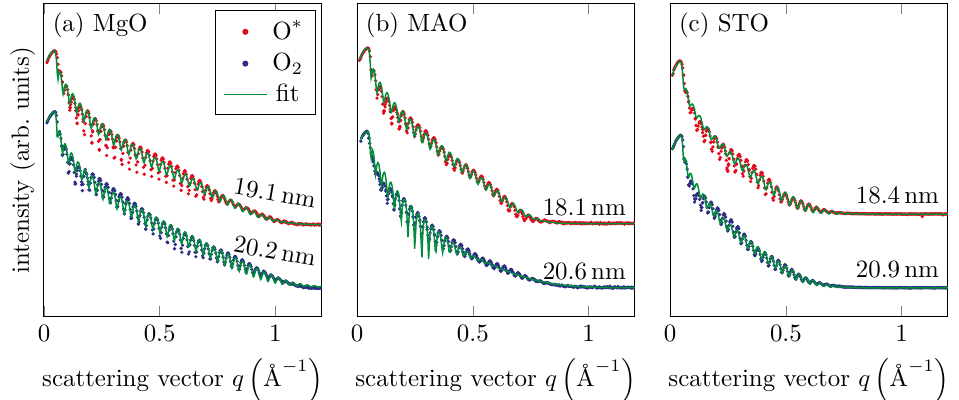
Figure 4. XRR measurements and fitted intensity curves of all films for ( a ) MgO substrate, ( b ) MAO substrate and ( c ) STO substrate. The fitted film thicknesses are shown on the respective curves.